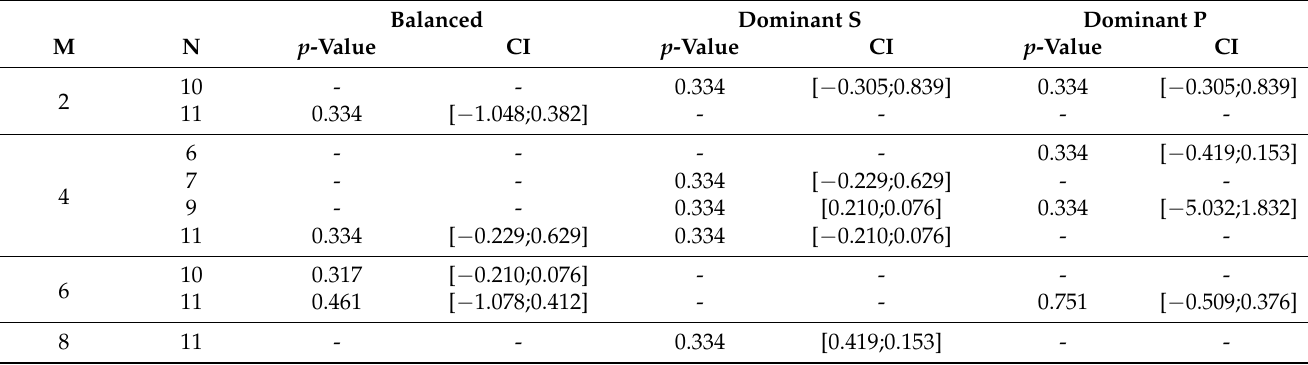
Table 3. Hypothesis test p -values and 95% confidence intervals for small problems.